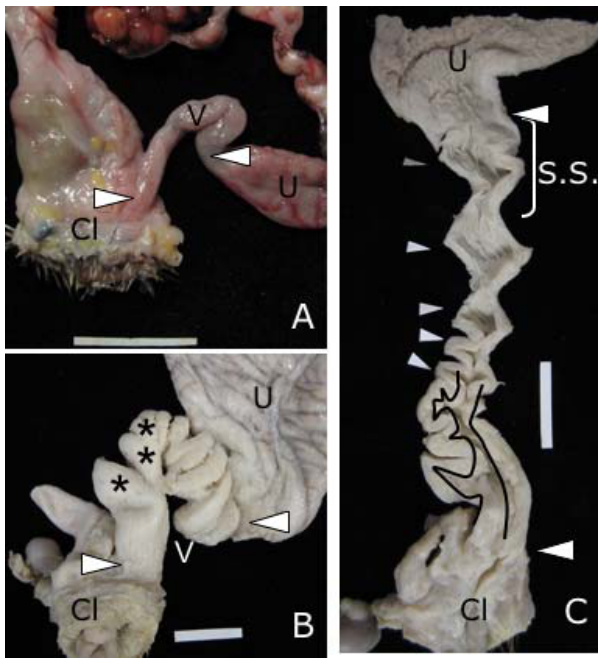
Figure 1. Avian vaginal morphology. (A) Typical tubular avian vagina from domestic Pheasant ( Phasianus colchicus ) (connective tissue removed). Note the lack of any elaborations. (B) Vagina (V) of Pekin duck (domestic Anas plathyrhynchos ) (connective tissue removed). Note the complexity of the structure. (C) Longitudinal dissection of Pekin Duck vagina showing structural complexity. Pockets (*) are closer to the cloaca (Cl) and their lumen in shown between the traces lines. Spirals (white arrows) are closer to the uterus (or shell gland) (U). S.S.=Area of sperm storage tubules. (Scale bar in all pictures=2 cm).